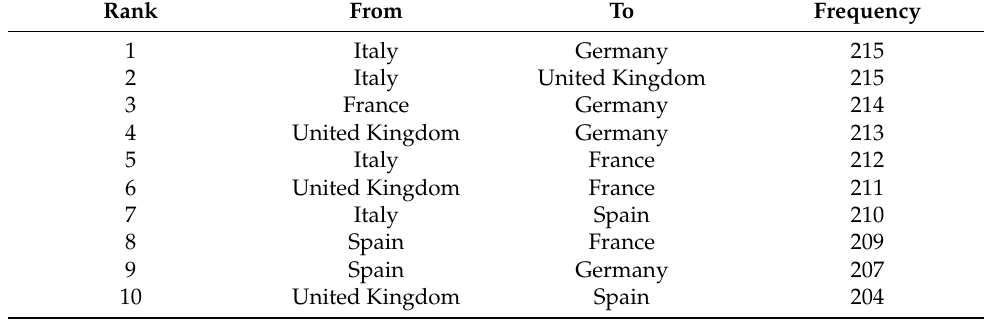
Table 6. Top 10 countries with the highest frequencies of collaboration.